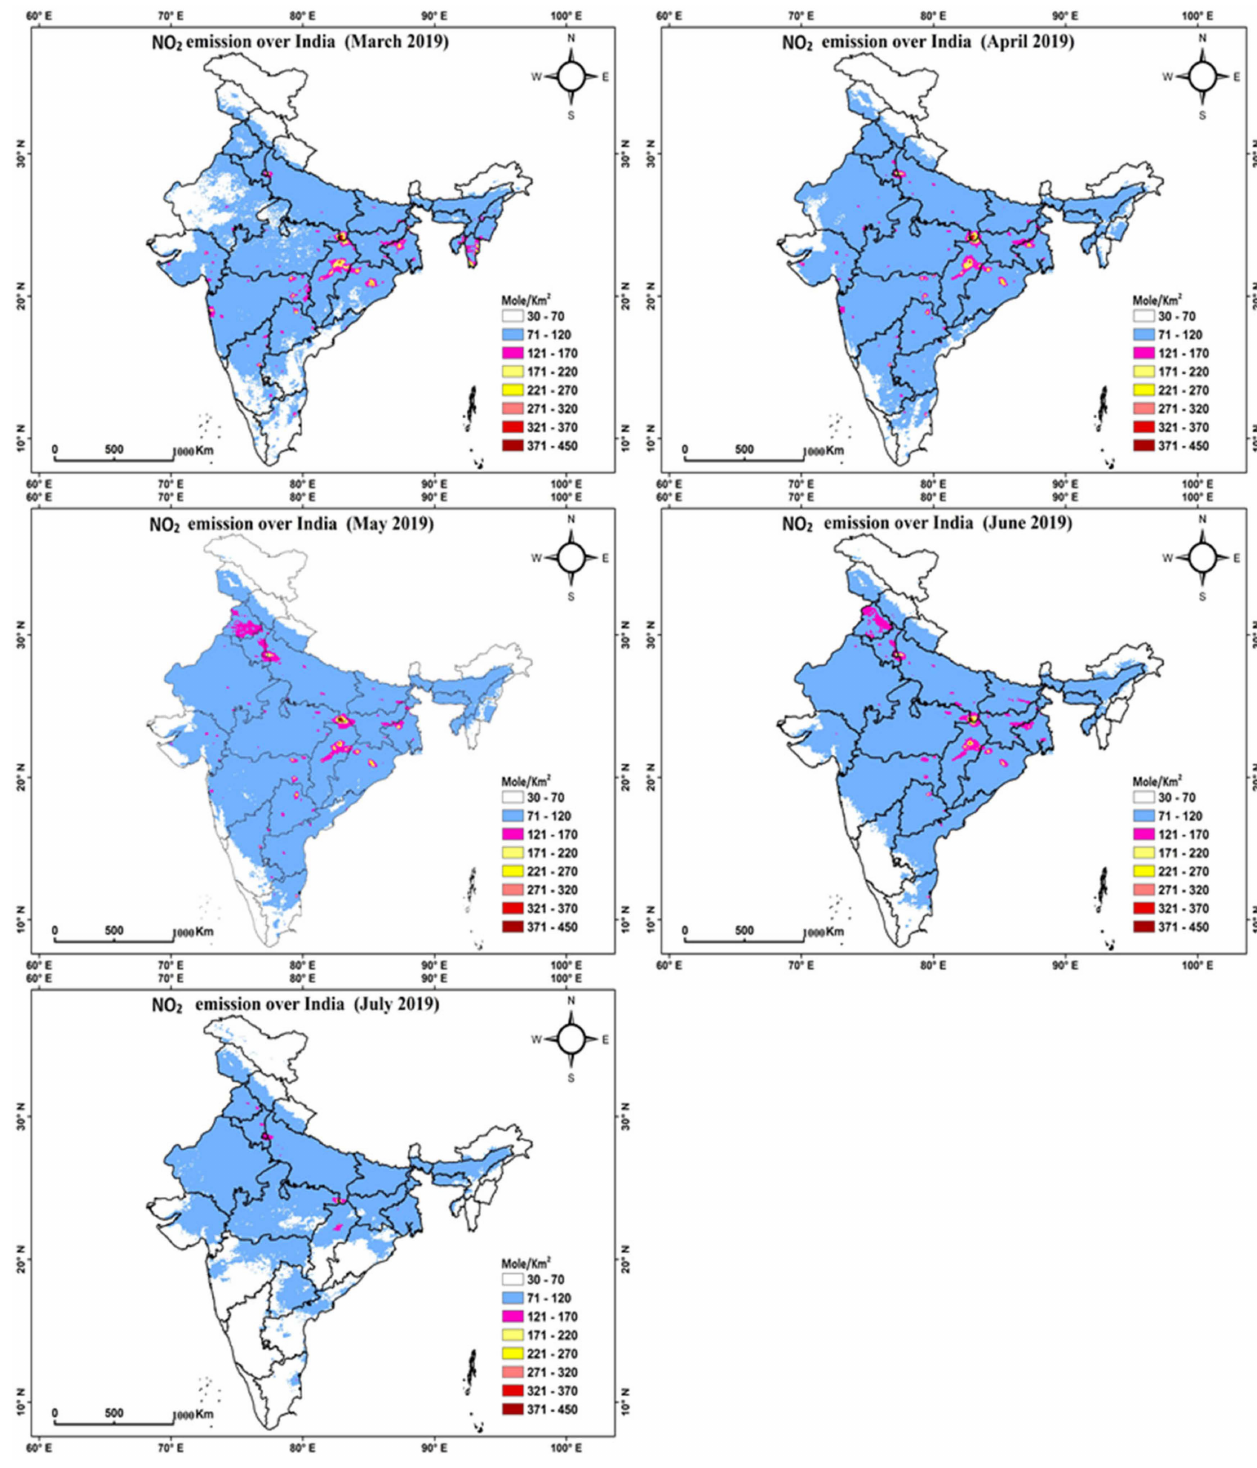
Figure 1. NO 2 emissions over India as observed by Sentinel-5P from March to July